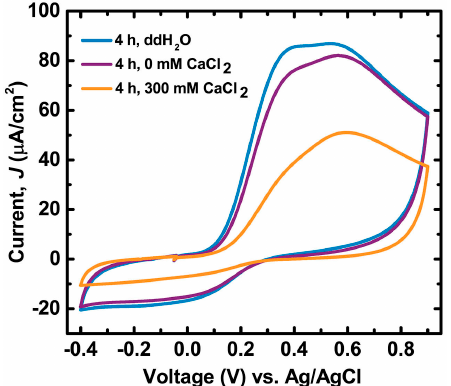
Figure 3. First cycle voltammograms of PDA films on indium tin oxide (ITO) that were incubated for 4 h in either ddH 2 O, 0 mM CaCl 2 50 mM Tris buffer pH = 9.5, or 300 mM CaCl 2 50 mM Tris buffer pH = 9.5. Electrolyte consisted of 180 mM sodium diphosphate–citric acid buffer and 100 mM NaCl at pH = 7.0 purged with N 2 . Scan rate was 30 mV/s. See Figure S8 for cycles > 1.